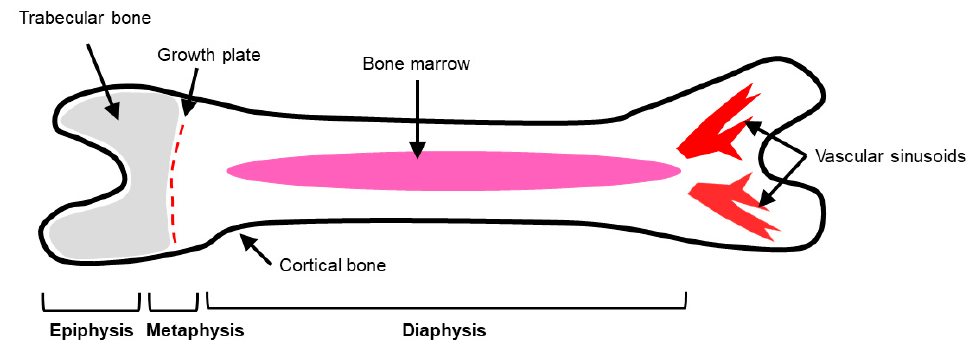
Figure 1. Gross anatomy of the long bones. Depicted are the three regions of long bones: epiphysis, metaphysis, and diaphysis. The outermost layer of bone is composed of densely packed cortical bone, while the interior and ends of bone are made up of trabecular bone (gray region). The growth plate is located in the metaphysis region and allows for longitudinal growth of bone. The bone marrow is located in the diaphysis, or shaft of long bones. Vascular sinusoids are located in the epiphysis of bone and allow for sluggish blood flow into the bone.